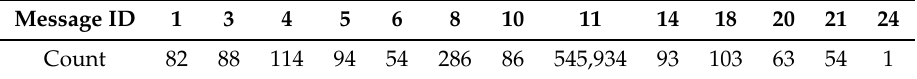
Table 1. Filtered PLOAMd message counts from captured data